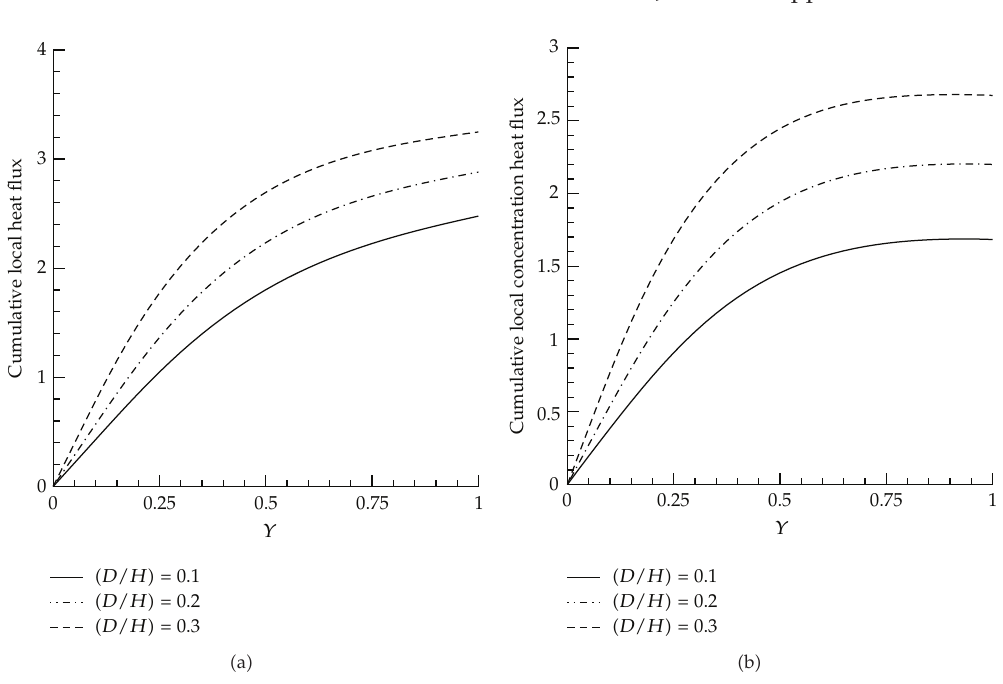
Figure 9: (cid:2) a (cid:3) Cumulative heat flux and (cid:2) b (cid:3) cumulative mass flux plots along the left vertical wall